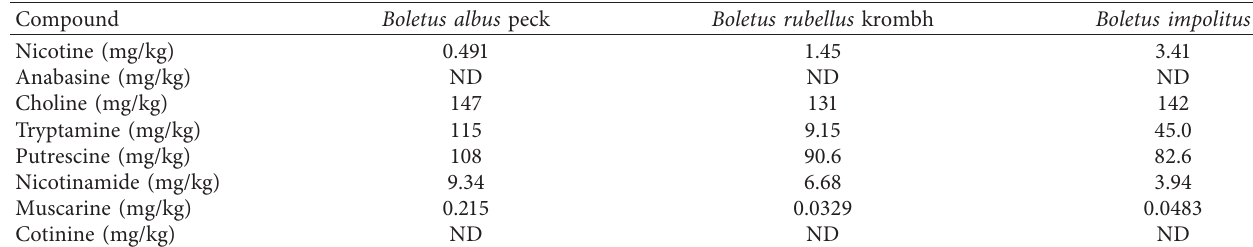
Table 4: Content of the 8 endogenous alkaloids in actual